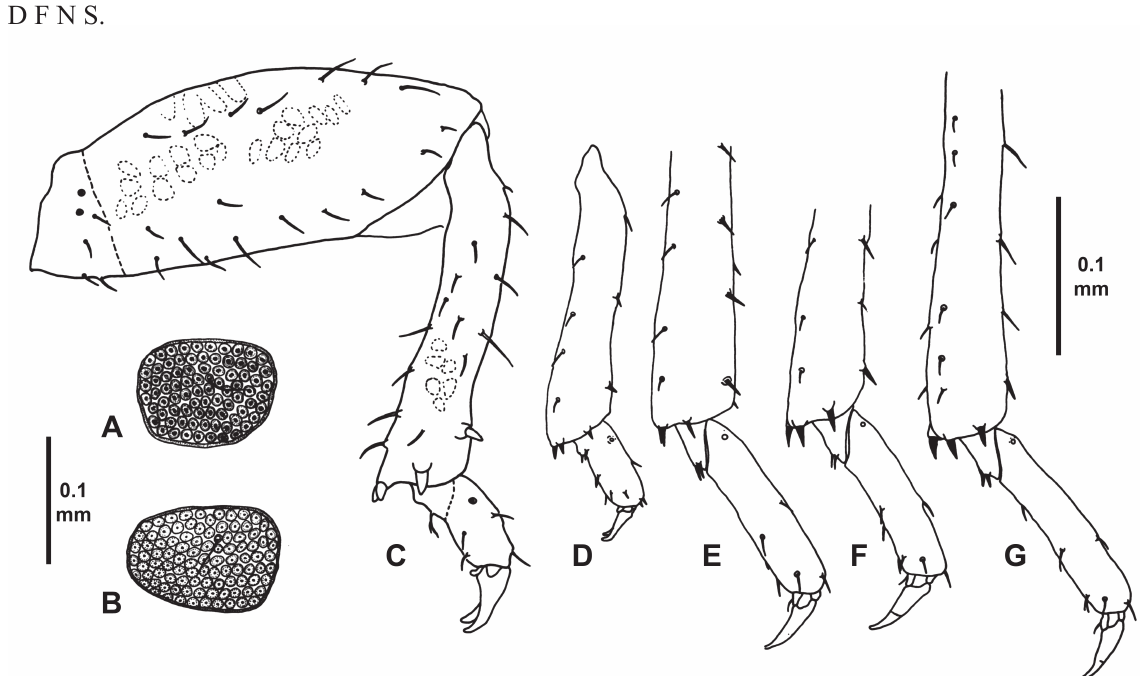
Fig. 19. Gootiella, Pachypappa and Pachypappella. Apt. alienicolae (born on secondary